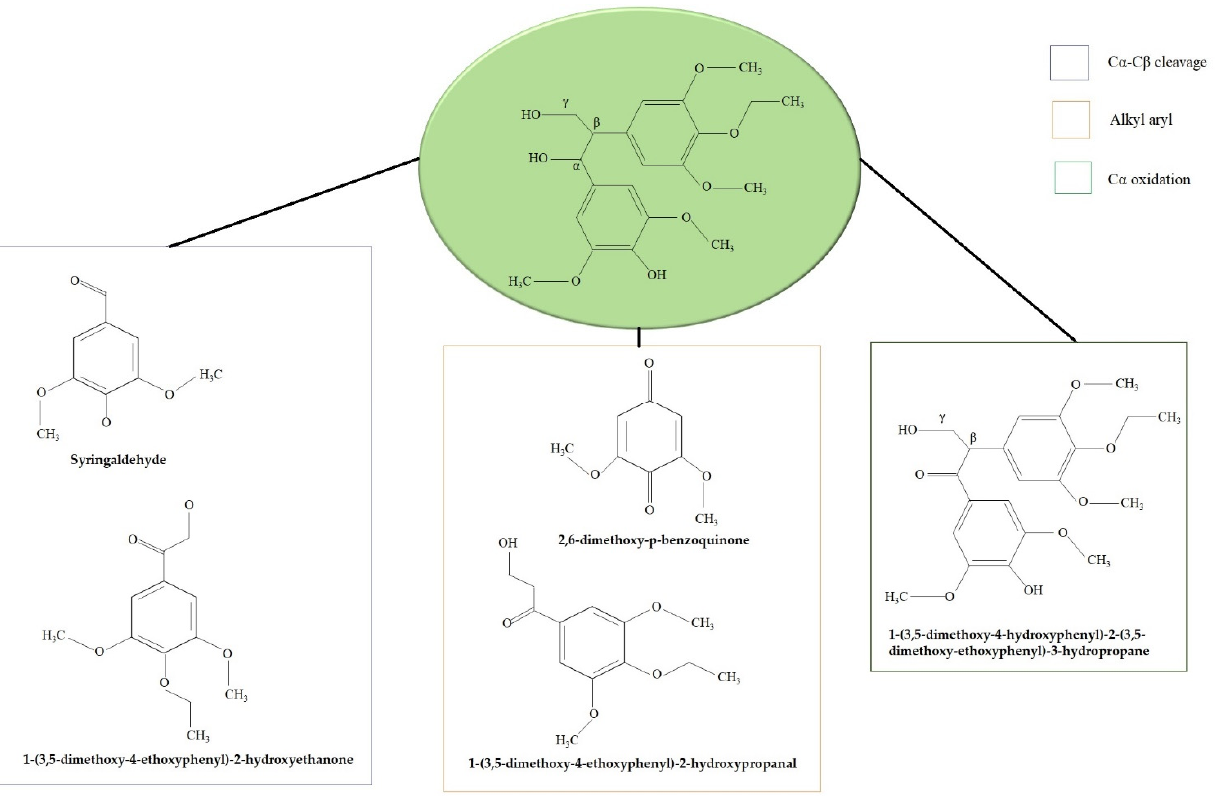
Figure 13. The mechanism involved in lignin depolymerization by laccase.